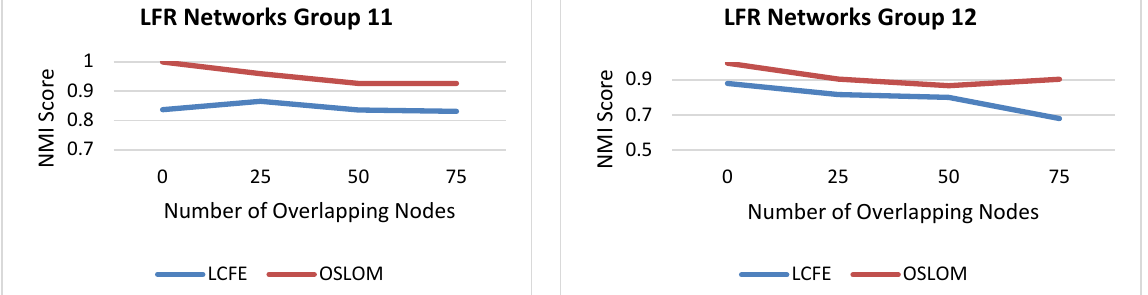
Fig. 11. NMI score comparison for LCFE and OSLOM for nineth group of LFR Networks with number of overlapping nodes ranging from 0 to 75